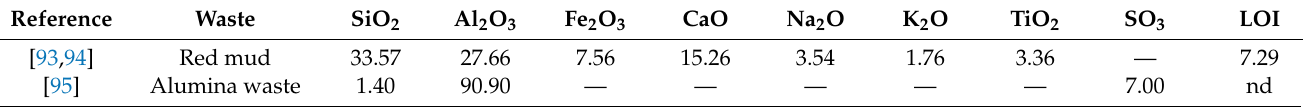
Table 4. Chemical composition (expressed wt.% oxide) of waste generated in the Bayer process.